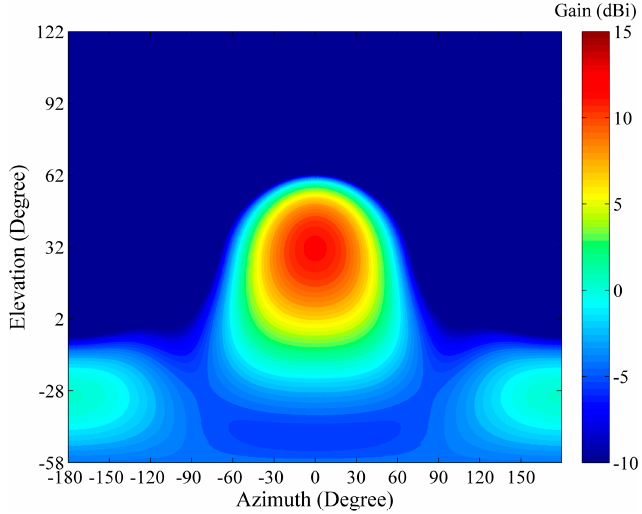
Figure 4. Computed radiation pattern of a single LPDA at 10 MHz (main lobe vector alignment), where dBi values are with reference to an isotropic gain pattern.